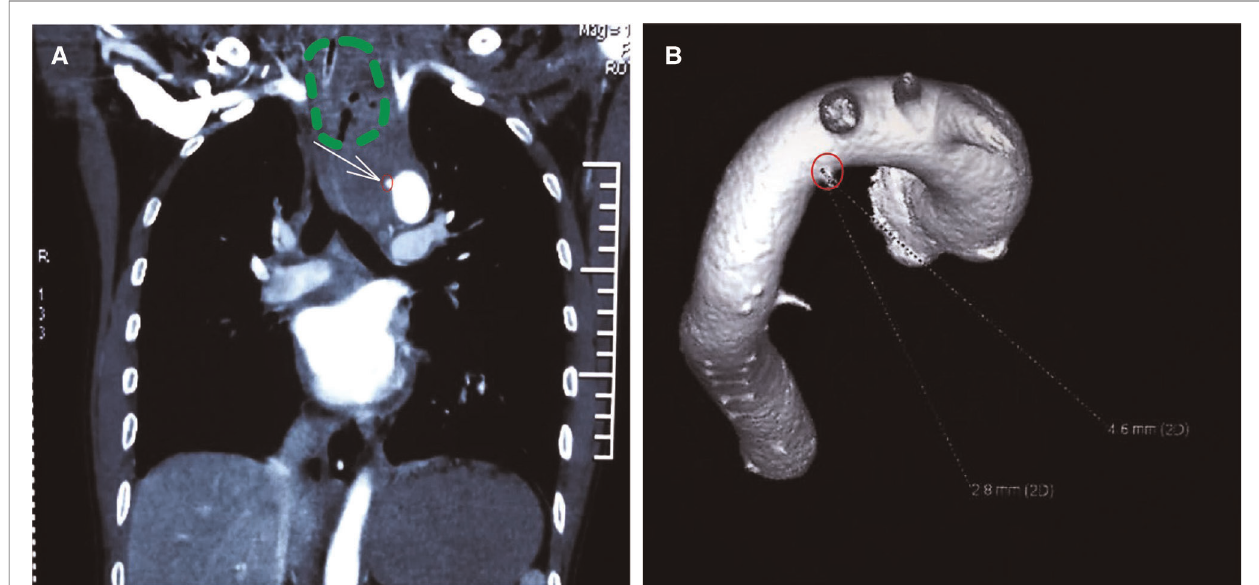
FIGURE 1 | Preoperative examinations. ( A ) Computed tomography angiography (CTA): coronal view of mediastinitis and aortoesophageal fi stula. Mediastinitis and gas accumulation with the green circle. The white arrow points to the leakage of contrast from the aorta, indicating a break in the aortic wall, within a small red circle. ( B ) Three-dimensional CT showed a break in the aortic wall (big red circle points to the aortic